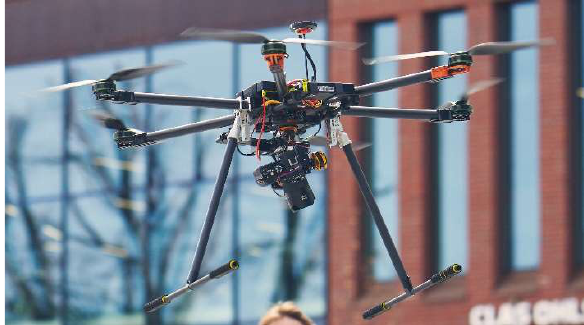
Figure 2. The finished survey drone in flight demonstration. © Aalto University